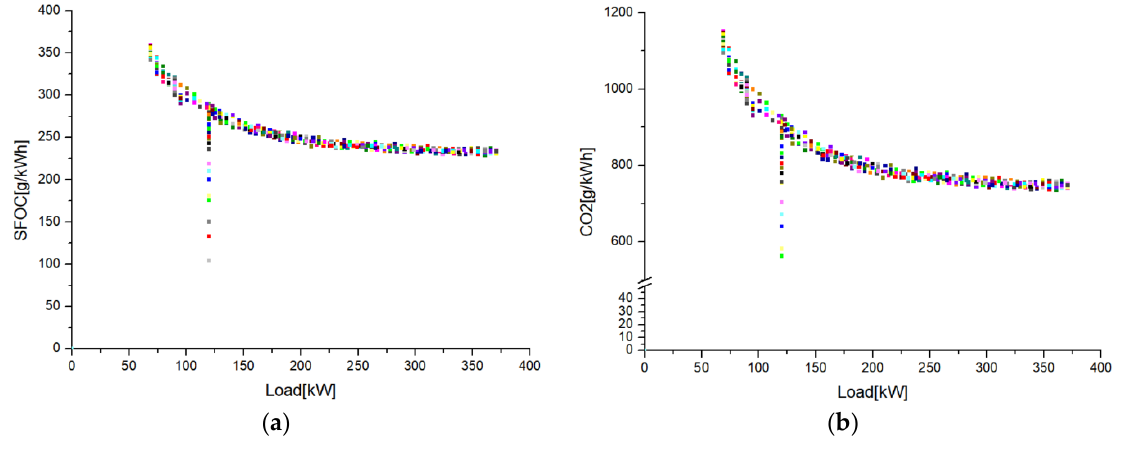
Figure 17. The results for the AC distribution system with constant speed mode; ( a ) SFOC, ( b ) CO 2 emission.